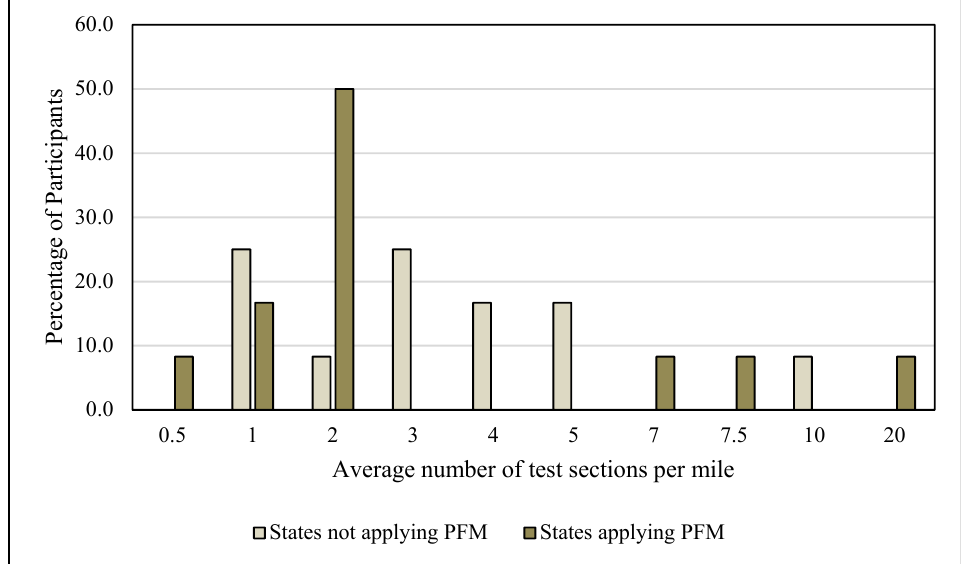
Figure 10. Average number of friction tests per mile for state DOTs.